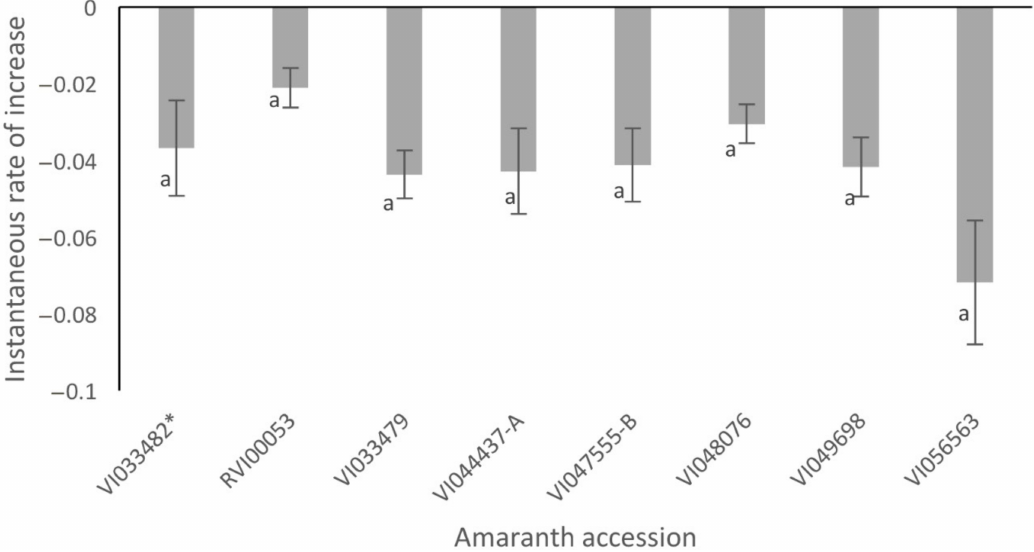
Figure 3. The mean instantaneous rate of population increase ( r i ) among larvae of Spoladea recurvalis when exposed to different amaranth accessions. Positive values of r i indicate a growing population, r i = 0 indicates a stable population, and negative r i values indicate a population in decline and headed toward extinction (Means with the same letter are not significantly different at p < 0.05 (Tukey’s test)). * Susceptible